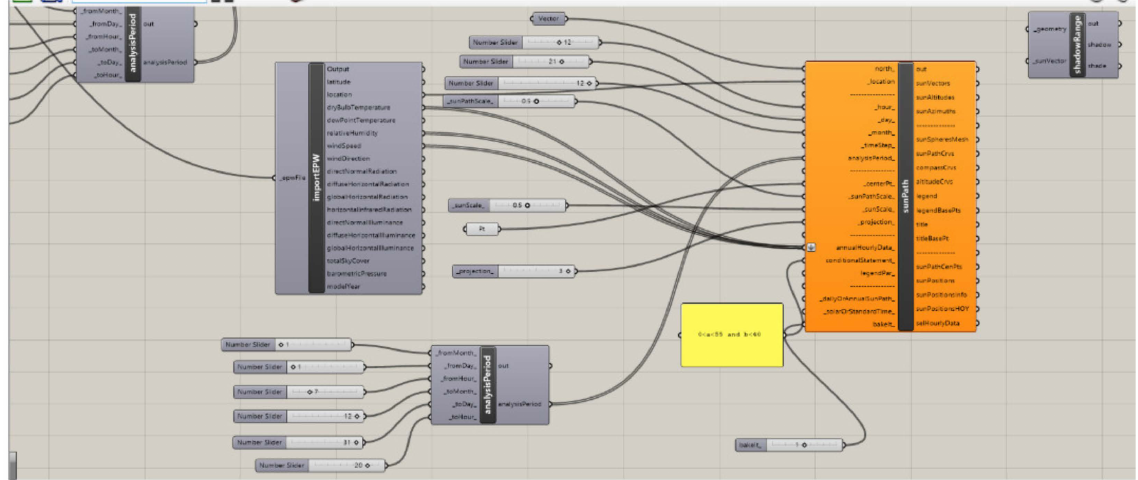
Figure 4. Python script for Grasshopper plug-in (illustration purpose only).